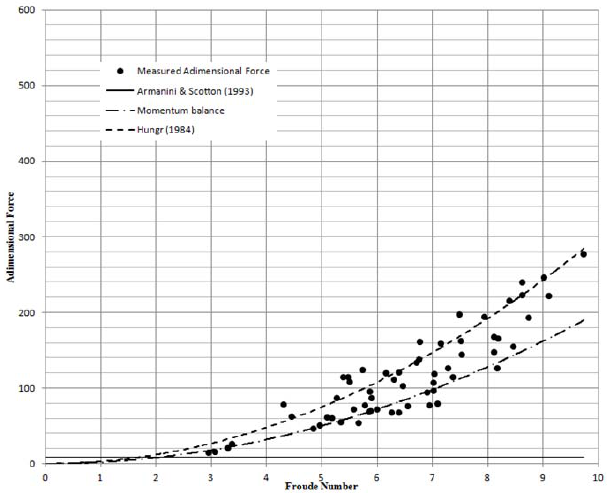
Fig. 5. Trend of the dimensionless force measured for tests con- ducted with vertical